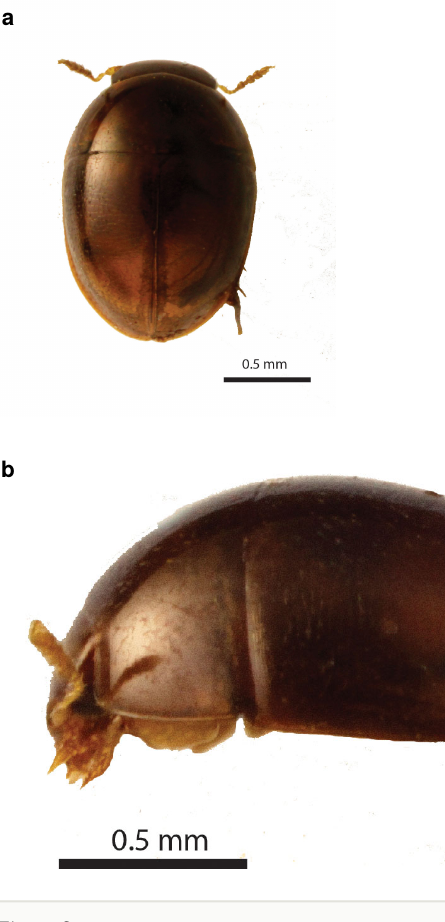
Figure 2. Colenisia chungi sp. n., morphology. a : Female, dorsal view (paratype, BOR/COL/14091) b : Female, lateral view (paratype, Head : Ratio of horizontal width of eye (measured in dorsal view and perpendicular to the longitudinal axis of the head) to distance between eyes: 1:7.4. Transverse microsculpture recognisable but too fi ne to distinguish individual cells at 50x